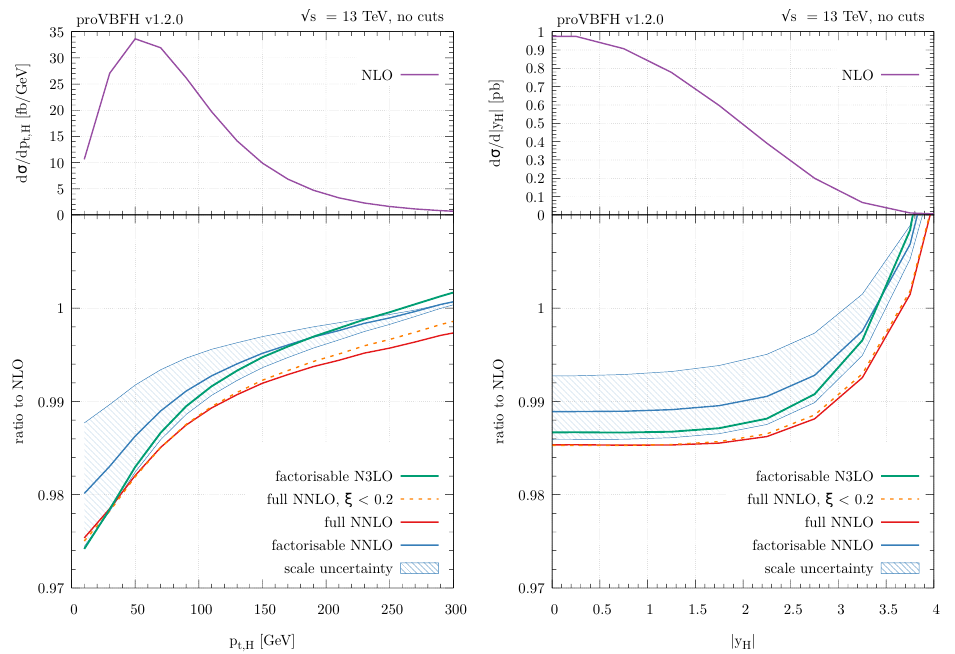
Figure 12. Upper panel: NLO prediction for inclusive VBF production for the transverse mo- mentum and rapidity of the Higgs boson. Lower panel: ratio of the factorisable NNLO prediction to NLO (blue) and of the full NNLO prediction to NLO (red). The blue bands represent the scale uncertainty of the NNLO factorisable prediction. The orange dashed curve shows the full NNLO- prediction after applying a cut (cid:24) < 0 : 2 on the non-factorisable component. The factorisable N 3 LO prediction is shown in